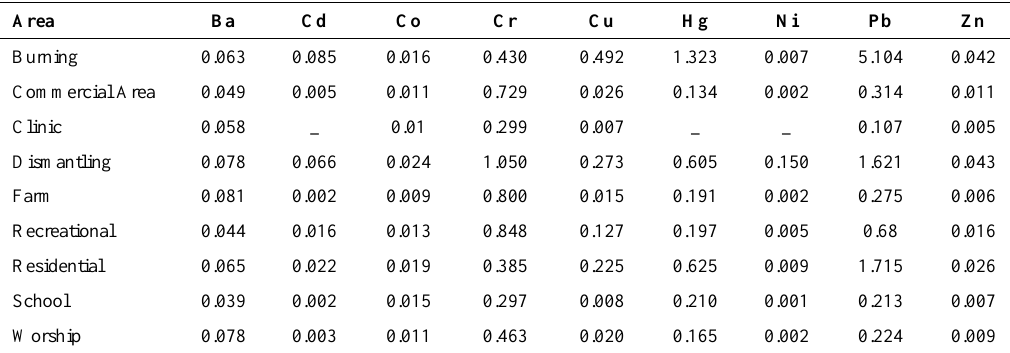
Table 3. Non-carcinogenic hazard indices